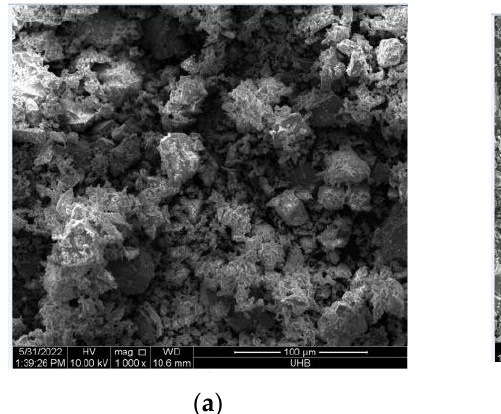
Figure 2. XRD diffractogram of the glass waste and cement powder.